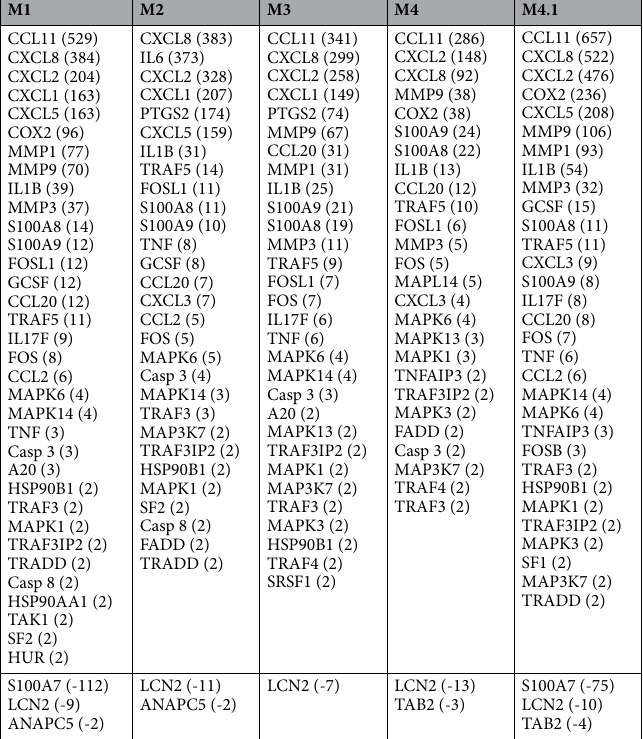
Table 4. Up-and downregulated genes in the IL-17 signaling pathway for all relevant M-stages. The fold change is shown between brackets behind the gene designation. The adjusted p-value is < 0.05. The fold change threshold is set at ≥ 2 for upregulated genes and ≤ -2 for downregulated